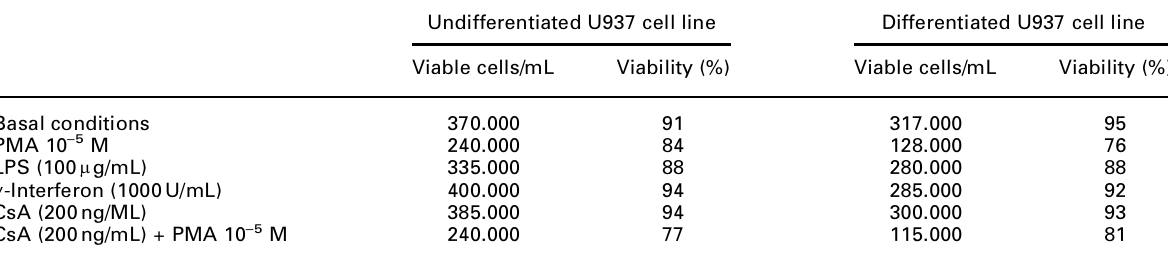
Table 2. Effect of CsA and different stimuli on cell proliferation and viability. In this study we started out with a viable cell concentration of 250,000/mL, obtaining the data after 18 hours of culture. CsA did not affect either the viability or proliferation capacity of either differentiated or undifferentiated cells. Additionally, both LPS and PMA, but not interferon, decreased cell viability. Definition of abbreviations: CsA, cyclosporin A; LPS, lipopolysaccharide; PMA, phorbol myristate